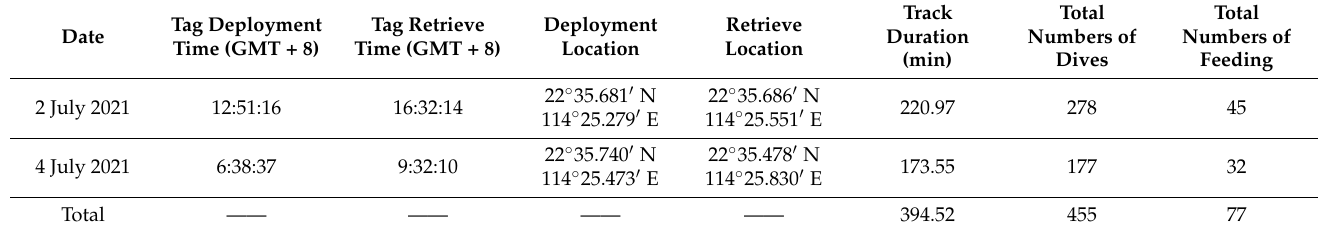
Table 1. Summary of tagging information on the Bryde’s whale in Dapeng Bay, China, on 2 and 4 July 2021.